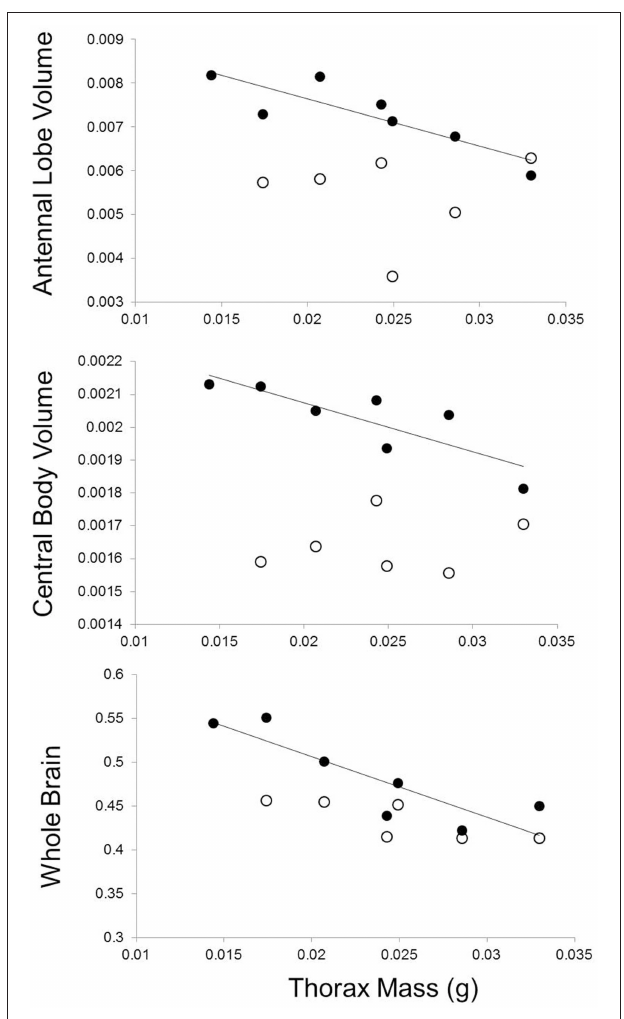
FIGURE 5 | Effects of relative thorax mass on neural investment. Full-sibling families with relatively smaller thorax mass at emergence developed larger brains and brain regions (experienced individuals shown with closed circles). There was no significant relationship between brain measures and thorax mass for brain measures taken on individuals sacrificed at emergence (open circles). Measures of individual brain regions account for body size